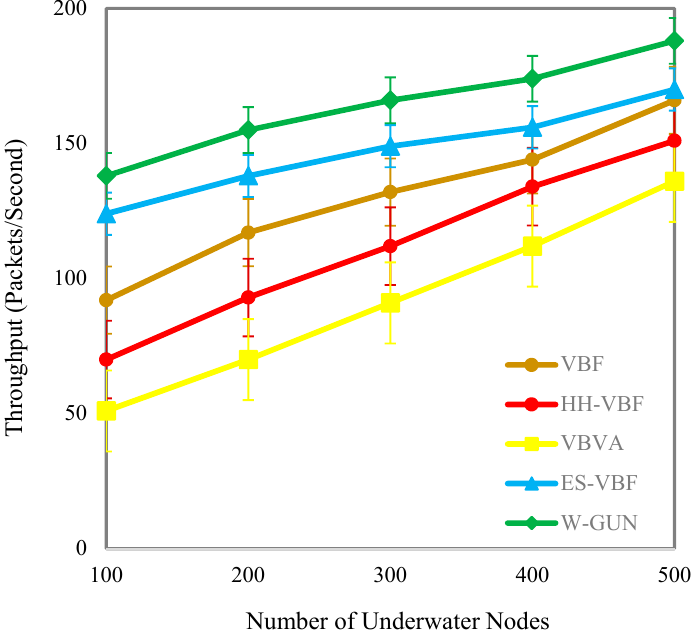
Figure 11. Throughput versus the number of underwater nodes. Table 5. Descriptive performance observation of W-GUN in terms of throughput.